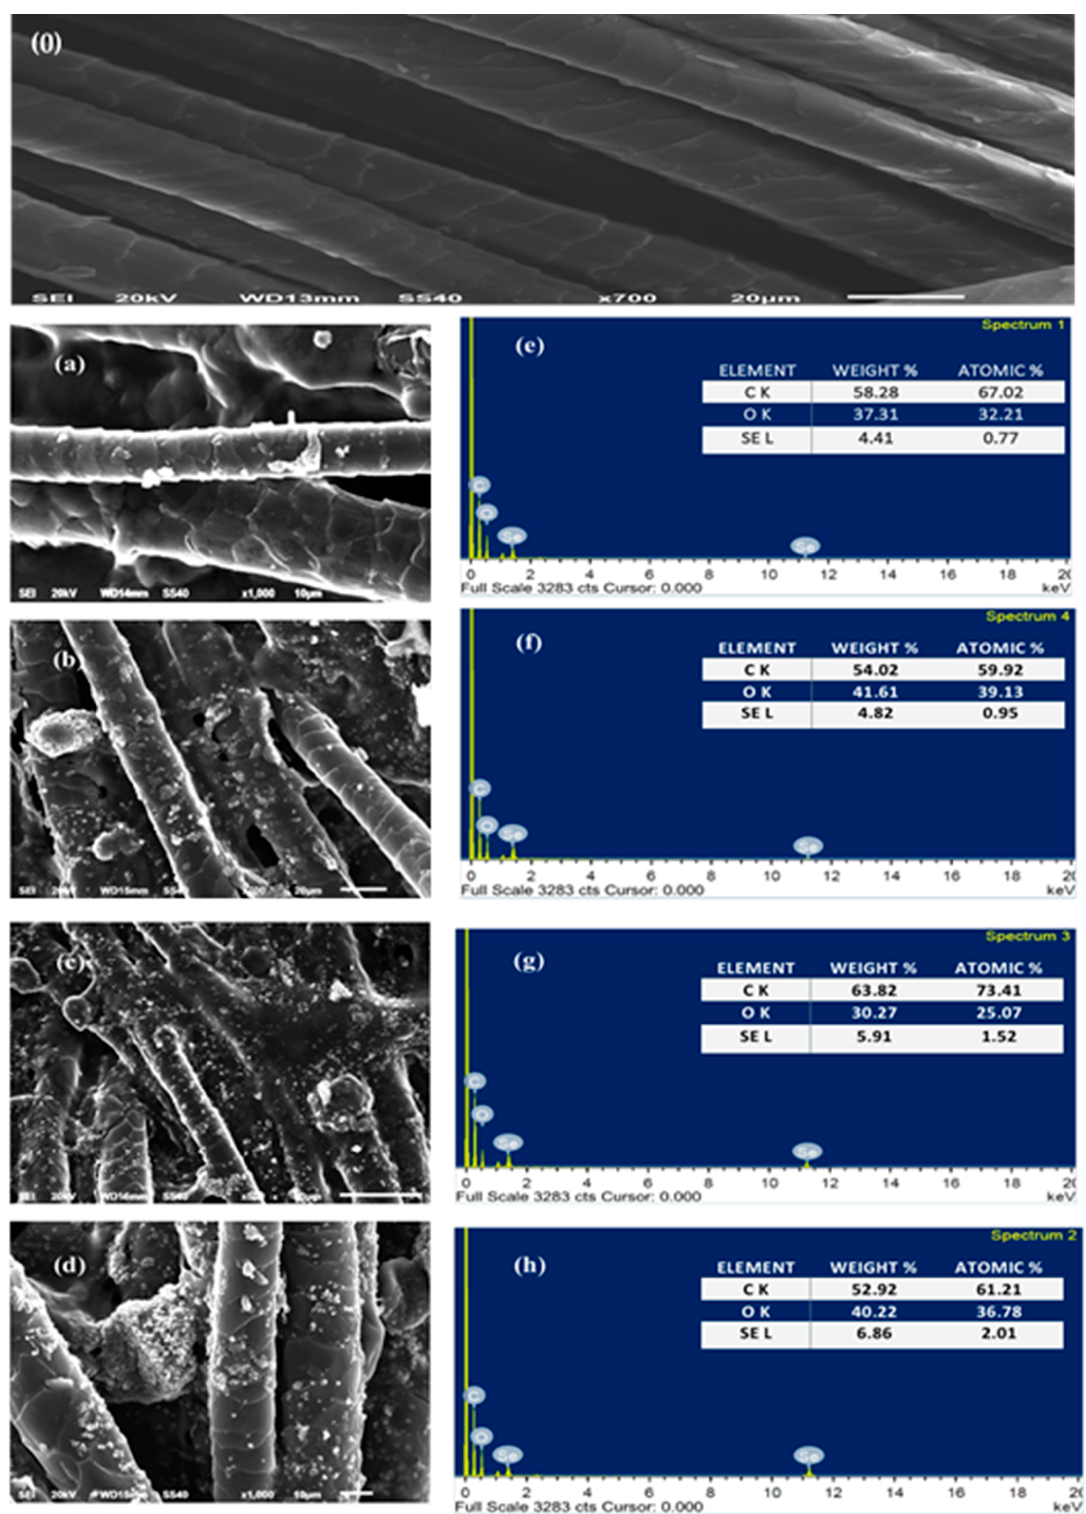
Figure 2. SEM micrographs of ( 0 ) blank wool fabric, and ( a – d ) wool fabrics dyed with Se-NPs at different concentrations of: ( a ) 12.5 mM, ( b ) 25 mM, ( c ) 37.5 mM and ( d ) 50 mM, as well as EDX spectra of Se-dyed wool fabrics with varied concentrations of: ( e ) 12.5 mM, ( f ) 25 mM, ( g ) 37.5 mM and ( h ) 50 mM.